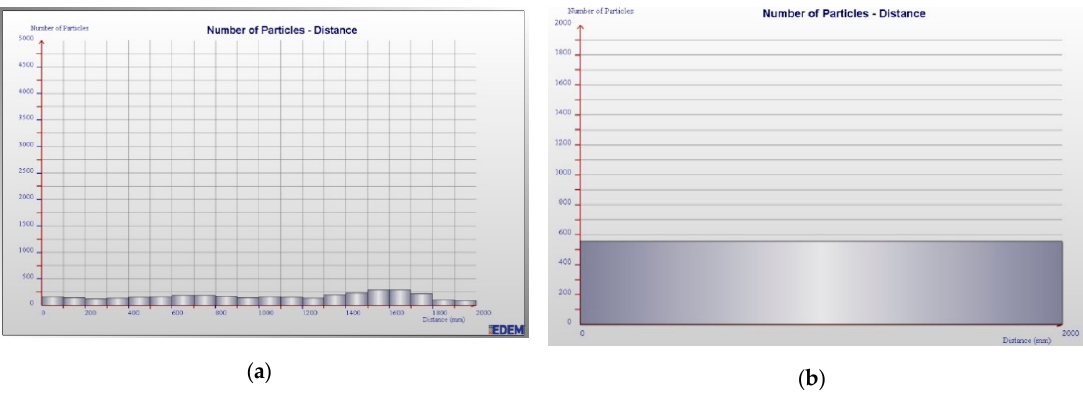
Figure 6. NZ value recorded: ( a ) number of particles in each small area of the dropping area; ( b ) the number of particles dropped in the whole dropping area.